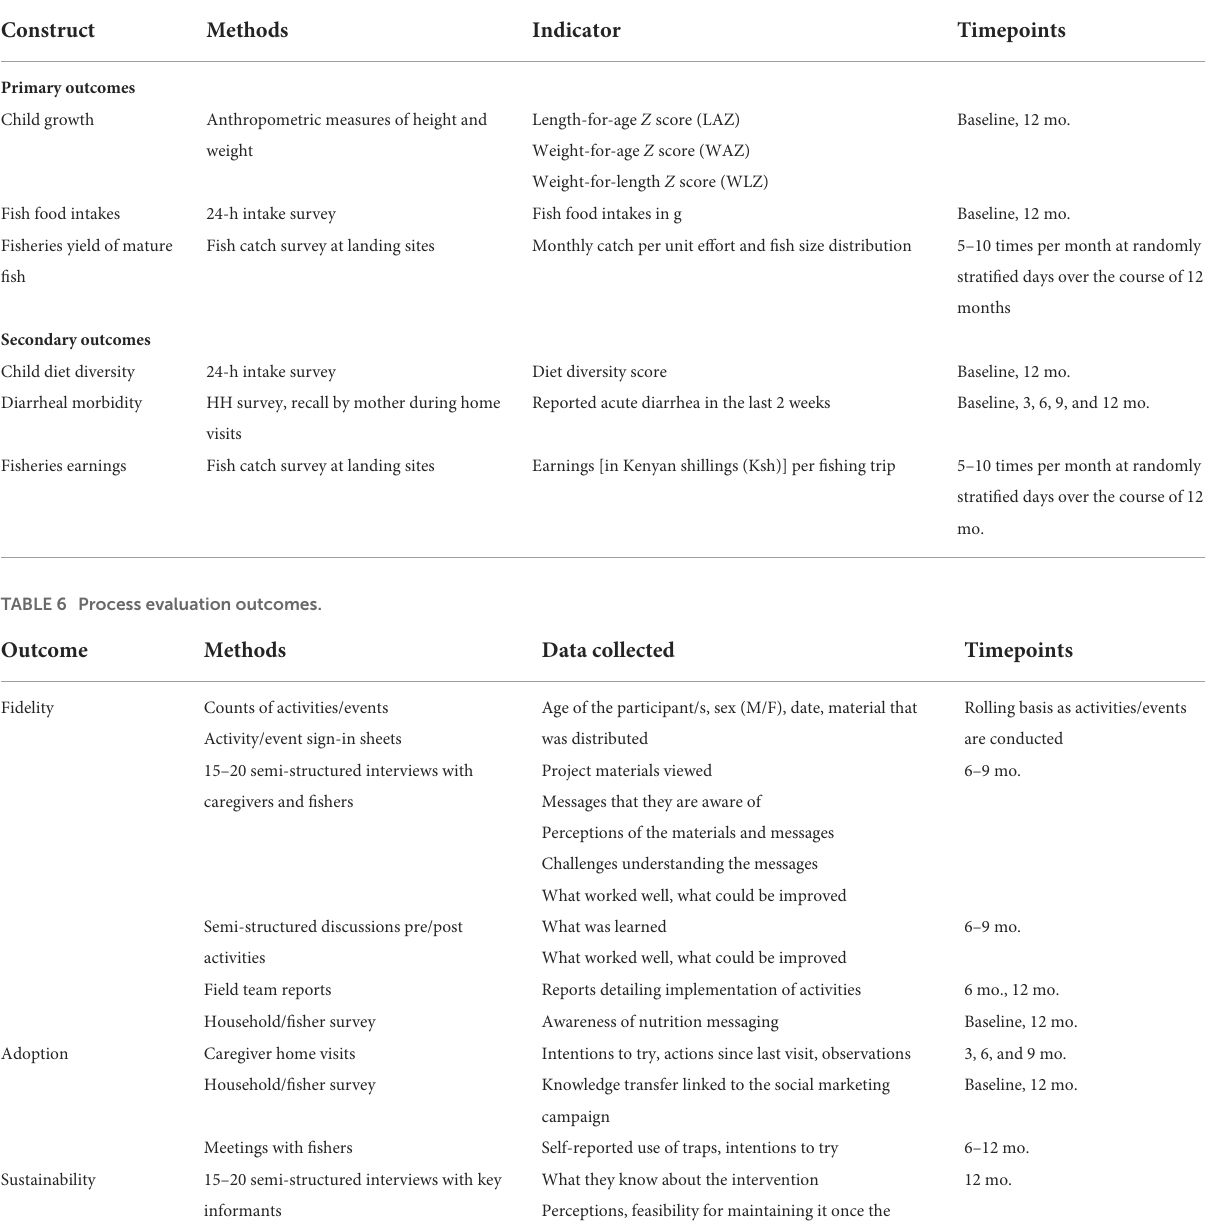
TABLE 5 Study outcomes.